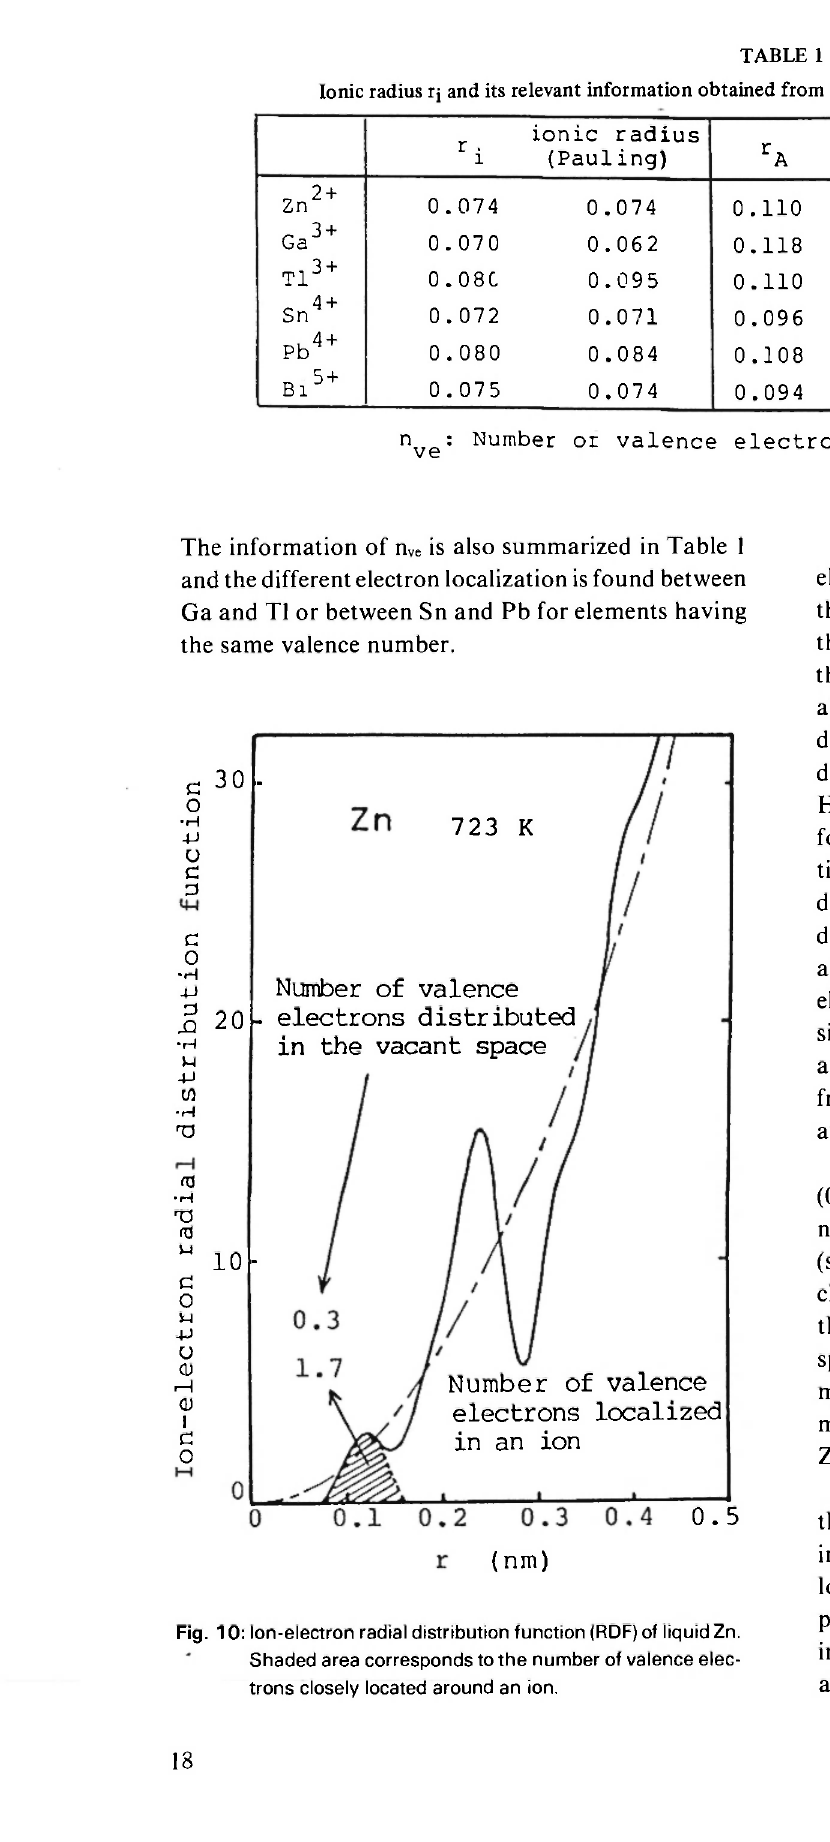
Fig. 10: Ion-electron radial distribution function (RDF) of liquid Zn. Shaded area corresponds to the number of valence elec- trons closely located around an